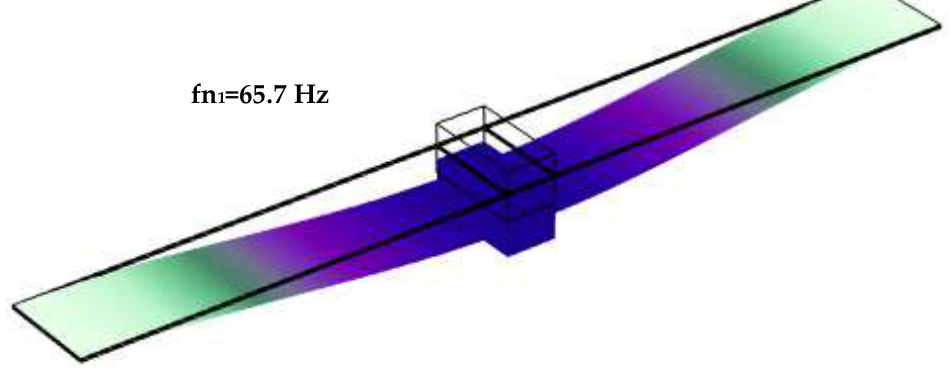
Figure 3. The first Eigen frequency of completely clamped beam.